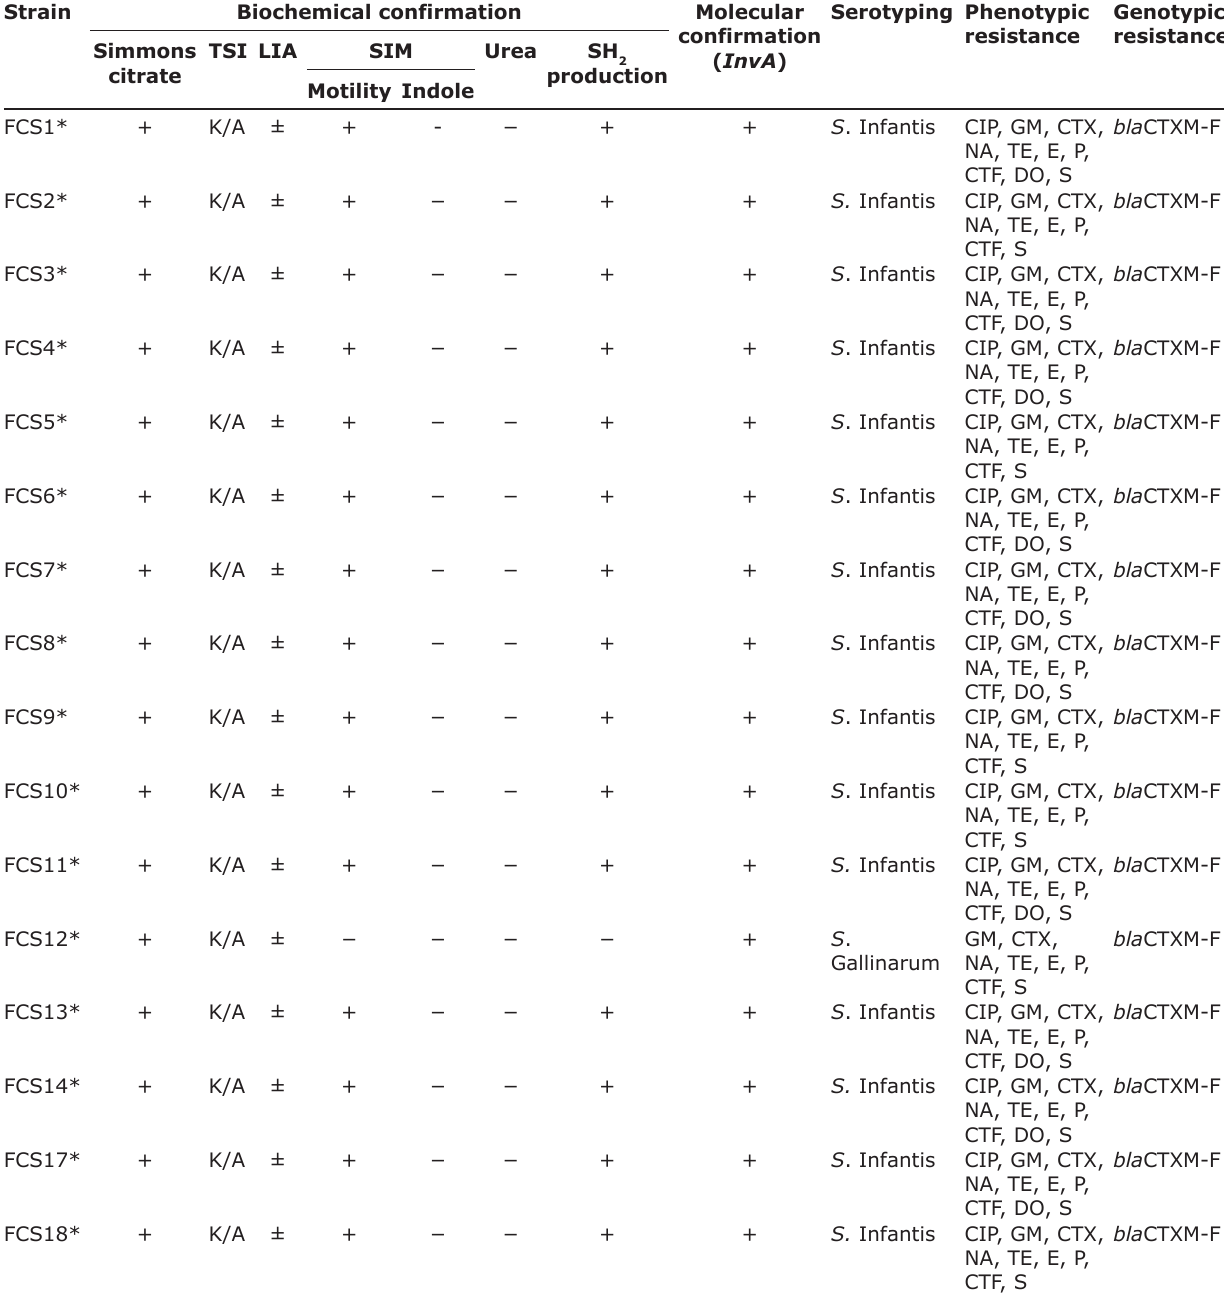
Table-1: Results of the microbiological and molecular tests carried out on the isolated strains of Salmonella spp.